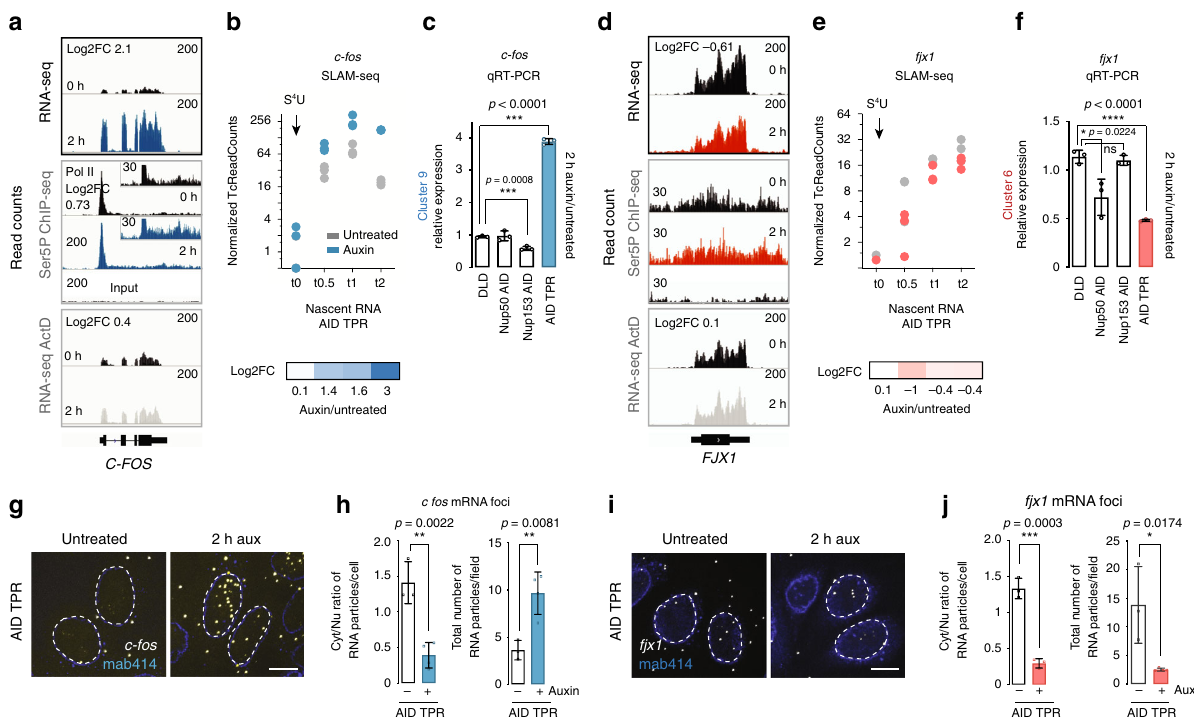
Fig. 6 TPR controls both transcription and RNA export. a , e IGV snapshots of RNA-seq, Ser5P Pol II ChIP-seq, and ActD RNA-seq results for two representative transcripts c-fos (blue) and fjx1 (red). Log2FC is shown separately for each experiment. We performed three and two independent biological replicates for RNA-seq and ChIP-seq experiments, respectively. b , e Top: Normalized T > C count plots for c-fos and fjx1 transcripts. Three independent replicates are shown on the plot. Bottom: Log2FC of T > C counts of auxin treated vs. untreated sample at each time point from three independent biological replicates (Supplementary Data 5). c , f qRT-PCR analysis of c-fos and fjx1 RNA abundance 2 h after TPR, NUP50, or NUP153 loss. Graphs show mean values of three technical replicates of one experiment, error bars are SD. Asterisks indicate p value *<0.1, ***<0.001, ****<0.0001 (unpaired two- tailed Student ’ s t test), ns non-signi fi cant ( p > 0.05). Exact p values are indicated on the graphs and in Source data fi le. g , i RNA-FISH analysis of localization of c-fos and fjx1 transcripts after 2 h of TPR loss. Note that both c-fos and fjx1 transcripts were retained within the nucleus. Data are representative of two independent experiments. h , j Quanti fi cation of cytoplasmic to nucleus (Cyt/Nu) ratio and total number of mRNA foci after TPR loss. Data are presented as mean values, error bars are SD. Asterisks indicate p value *<0.1, **<0.01, ***<0.001 (unpaired two-tailed Student ’ s t test). Three independent fi elds from two independent experiments were used for c-fos (untreated cells, n = 51; auxin-treated cells, n = 69 for AID-TPR cell line) and fjx1 (untreated cells, n = 30, auxin-treated cells, n = 50) mRNA foci quanti fi cation. Exact p values are indicated on the graphs and in Source data fi le. FC fold